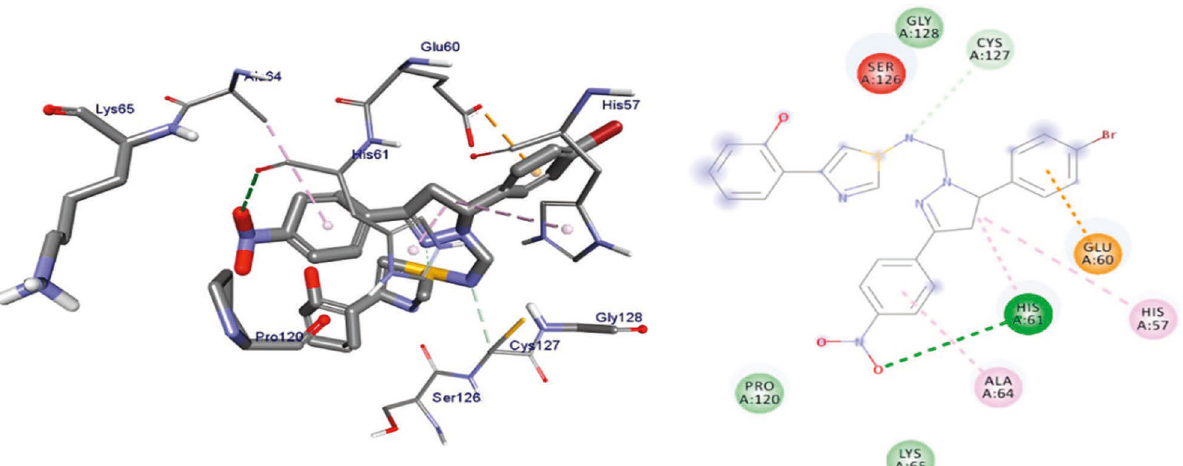
Figure 8: 3D (a) and 2D (b) representations of the binding interactions of 21 against LuxS of S. pyogenes .